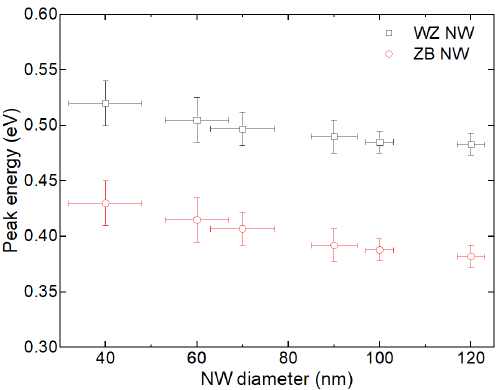
Figure 5. Peak energy shift of the spectra in Figure 4 versus nanowire diameter. Error bars represent the uncertainty in the measured NW diameter and the peak